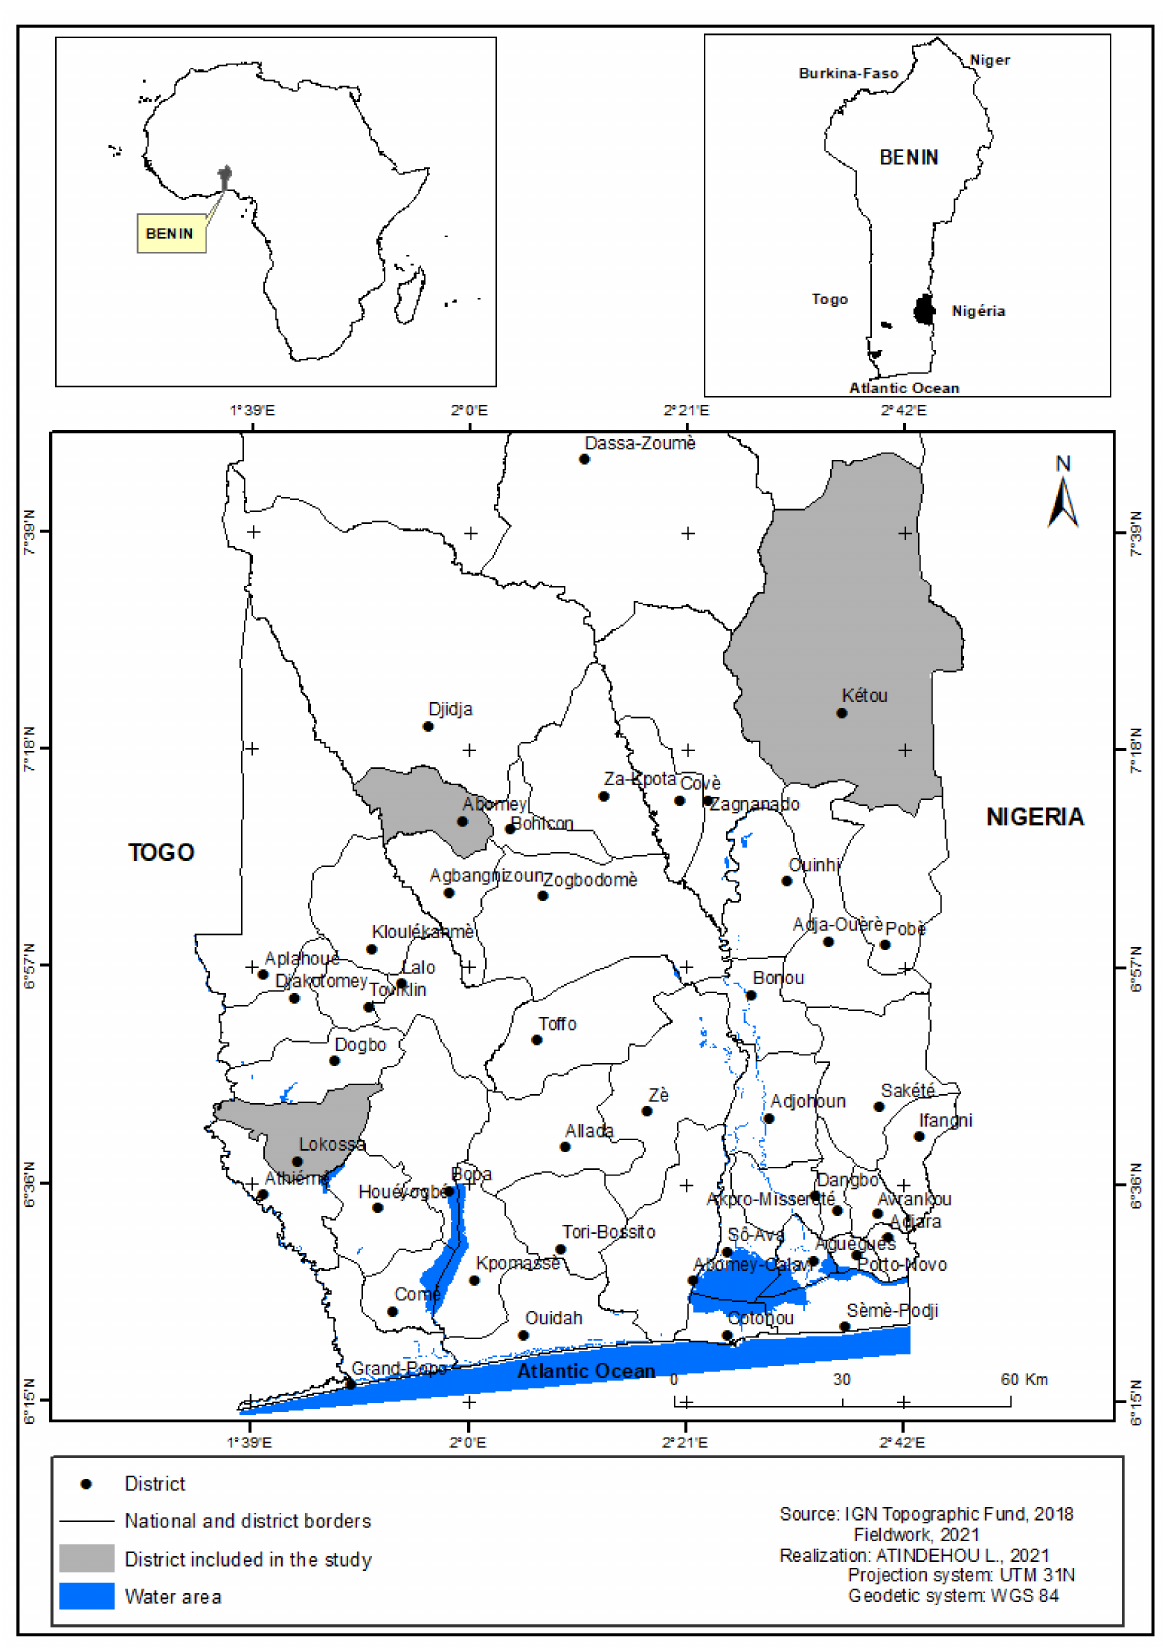
Figure 1. Map of study areas in which data on LOTs were